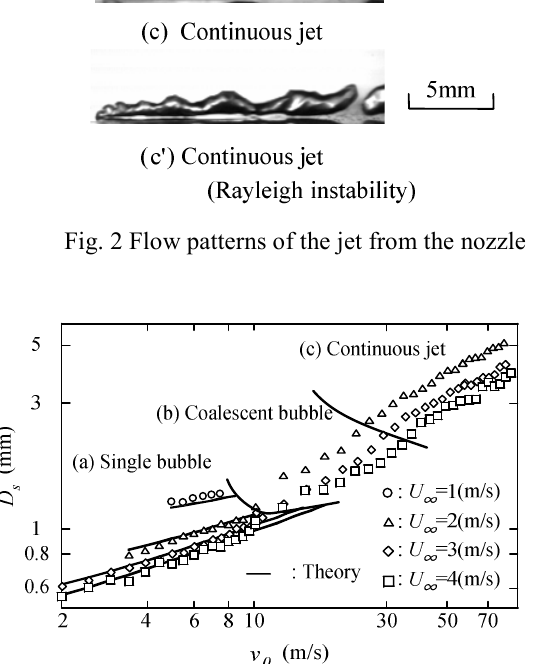
Fig. 3 Experimental results of the bubble diameter for each pattern of bubble separation ( d = 0.32 mm 0